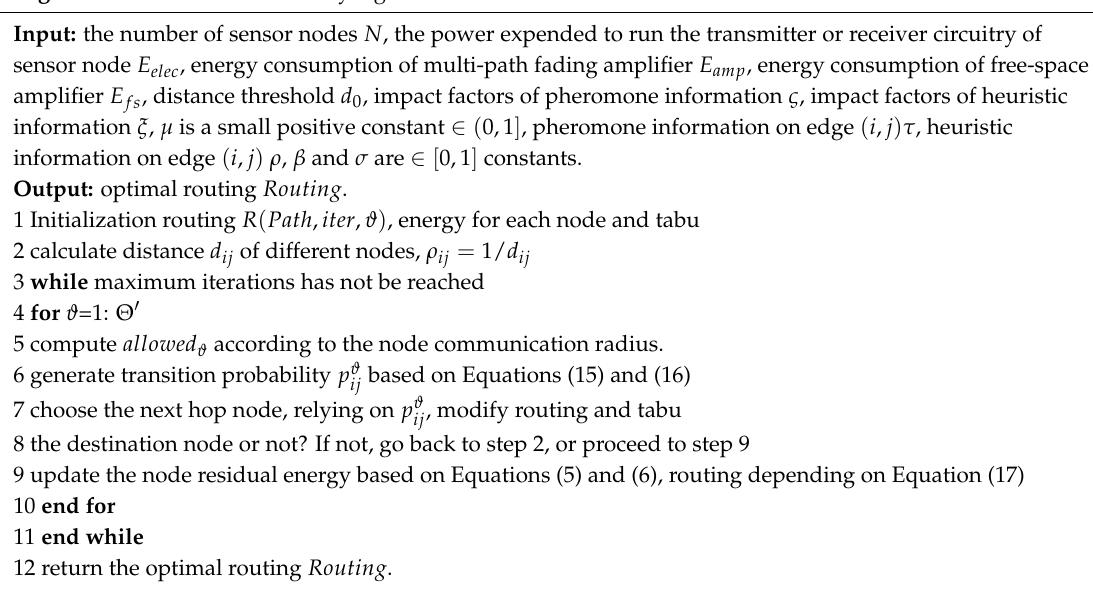
Algorithm 2. Modified ant colony